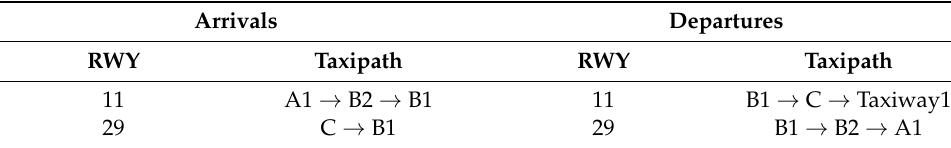
Table 4. Summary of taxipaths.